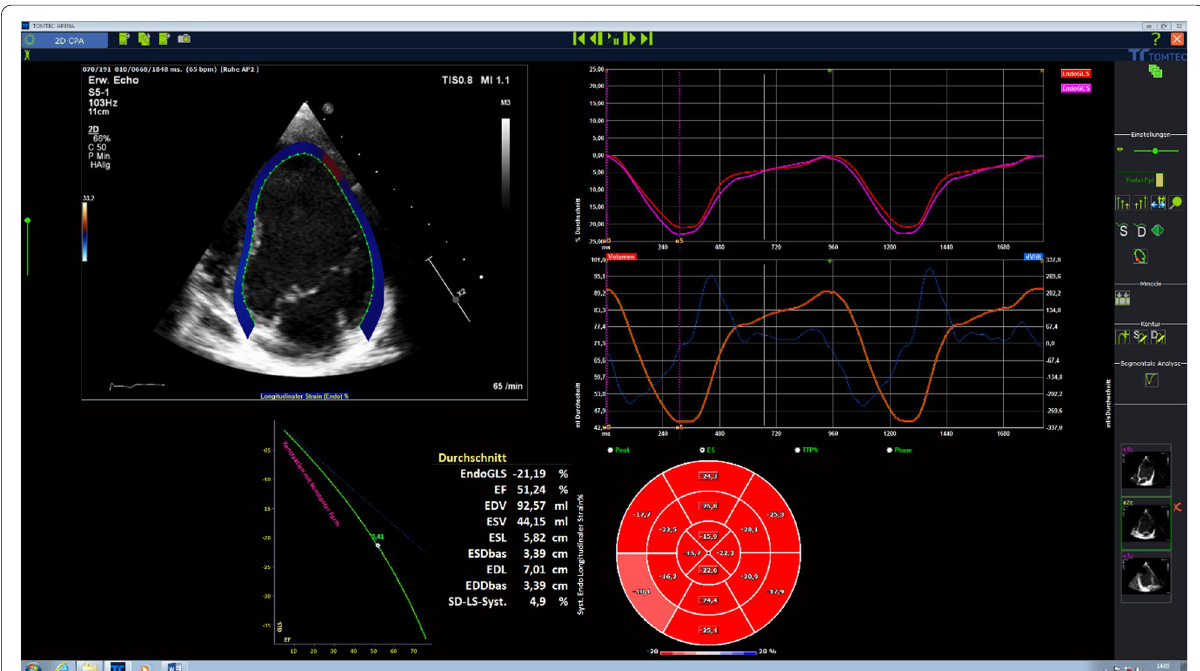
Fig. 1 2D strain imaging allows the assessment of global and regional function based on the determination of qualitative and quantitative parameters (longitudinal, radial, circumferential strain): vendor-independent analysis software tools (such as the Tomtec 2D-CPA analysis) visualize LV myocardium, strain curves, and summarize the results in “bull-eye” plots, generating a fast and comprehensive overview on cardiac